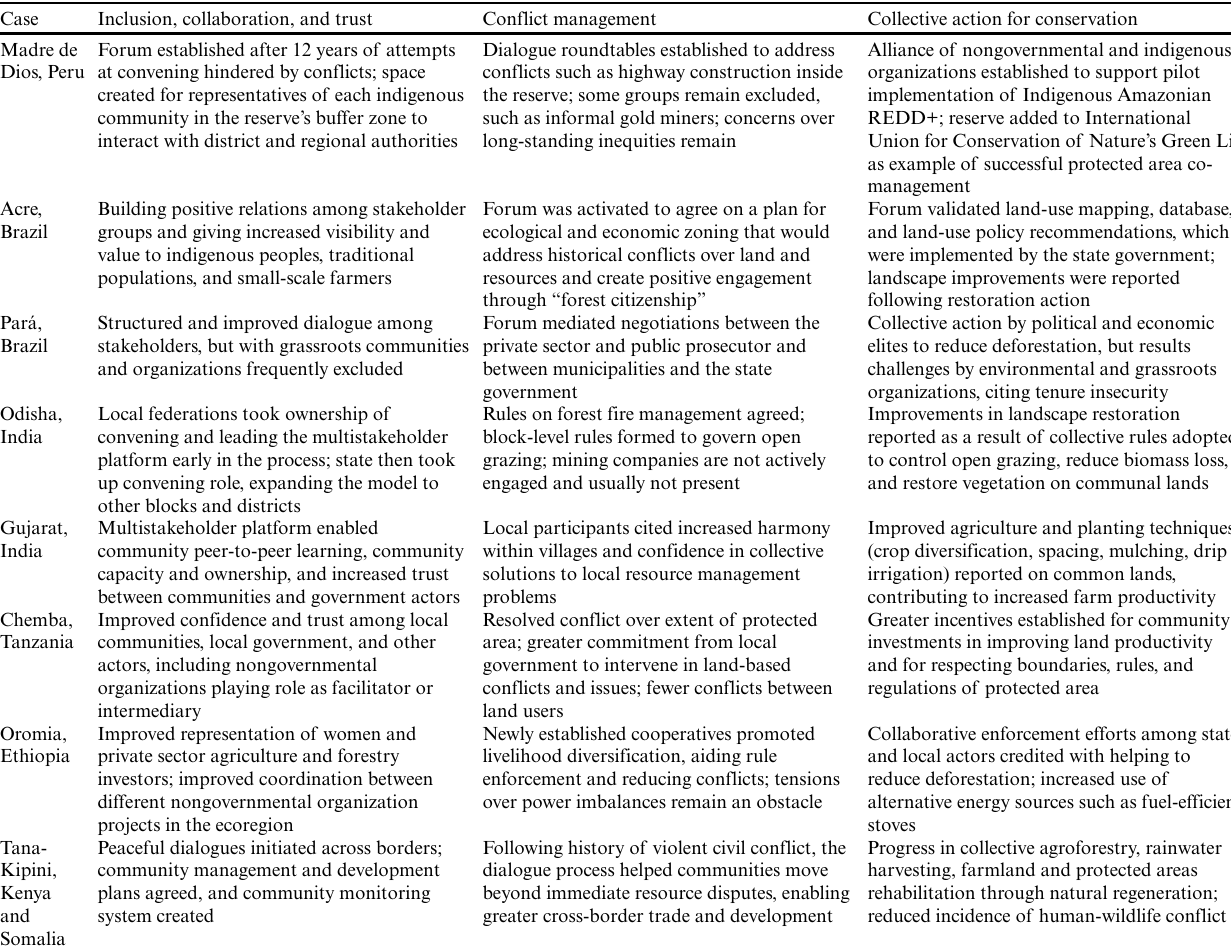
Table 2. Summary of case outcomes and multistakeholder platform influence on patterns of stakeholder